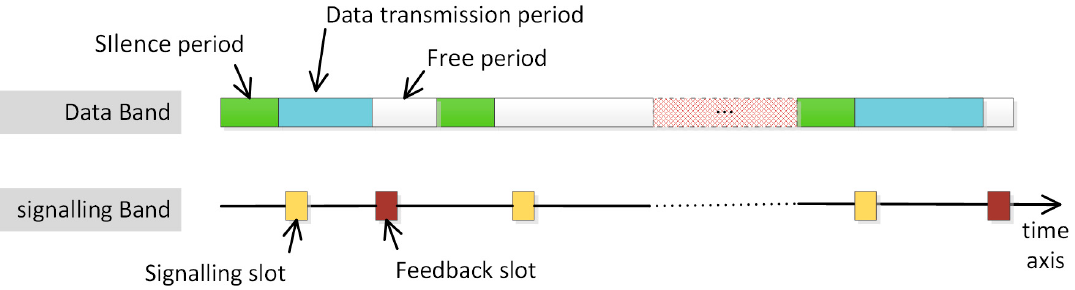
Figure 3. The time sequence diagram of the system information interaction.